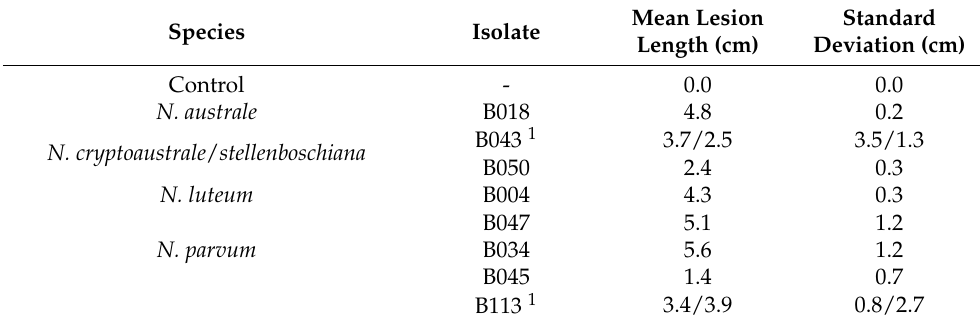
Table 5. External symptoms (length of necrotic lesion) caused by Neofusicoccum species in West Indian avocado seedlings 21 days after inoculation in pruning-cut